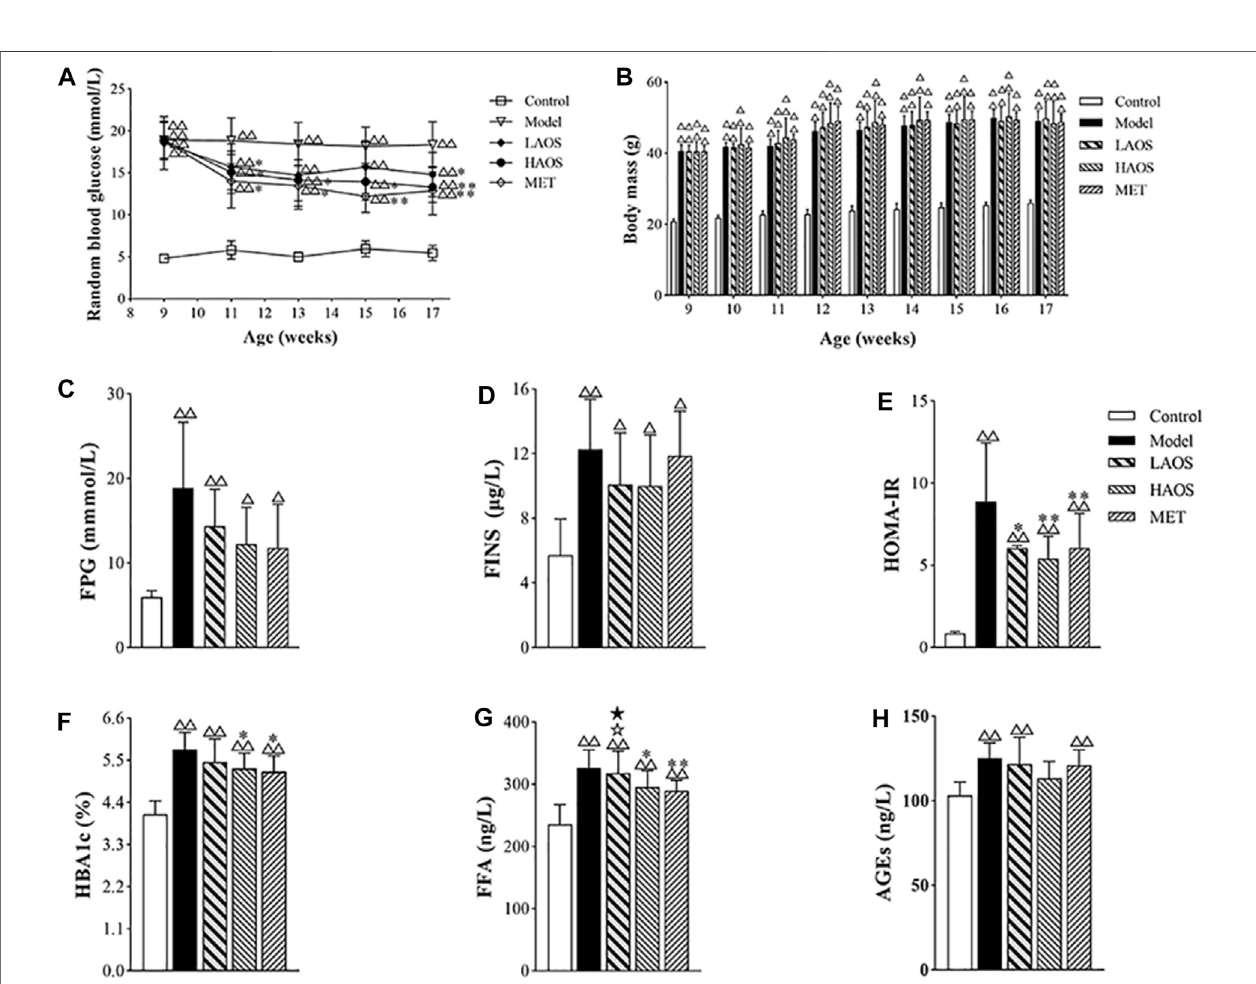
FIGURE 2 | Effects of AOS on glucose metabolism in db/db mice. (A) RBG level of the different groups after 8 weeks. (B) Body mass of different groups at 9 – 17 weeks.Distilledwater,metformin(MET),orAOSwasadministeredorallyto9-week-oldcontrolormodelgroupfor8weeks,andFPG (C) ,FINS (D) ,HOMA-IRindex (E) , HBA1c (F) , FFA (G), and AGEs (H) weredetermined. All values are expressed asthe mean ± SD(n (cid:1) 10). △△ p < 0.01 versusthe control group; * p < 0.05, ** p < 0.01 versus the model group. q p < 0.05 versus MET group; + p < 0.05 versus HAOS group. The values were presented as mean ± SD (n (cid:1) 10).